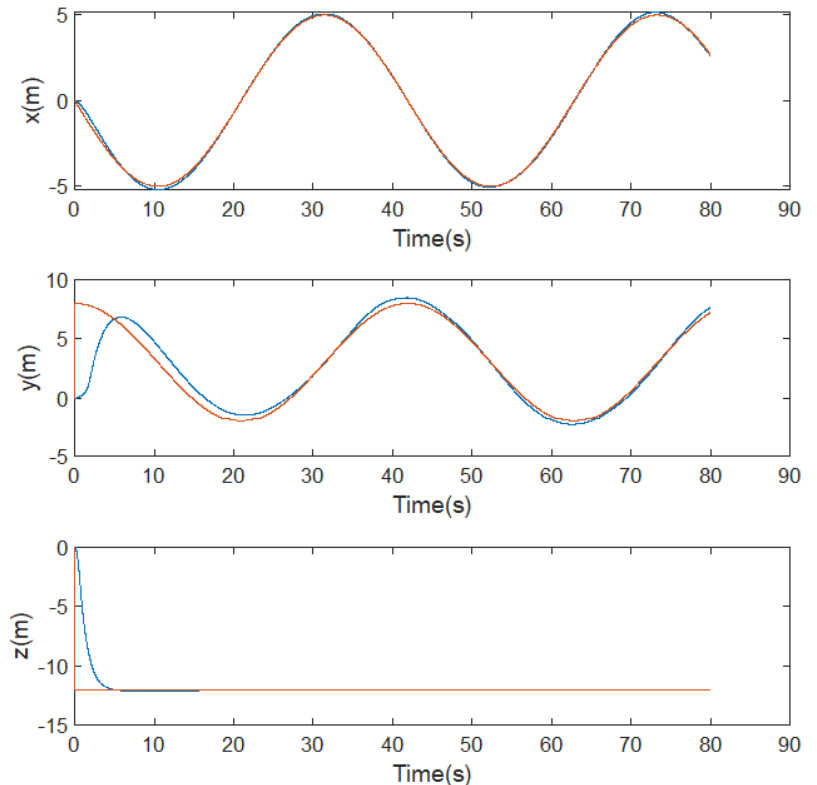
Figure 20. Multiplication fault : the position control performance (red line–desired, blue line–actual).